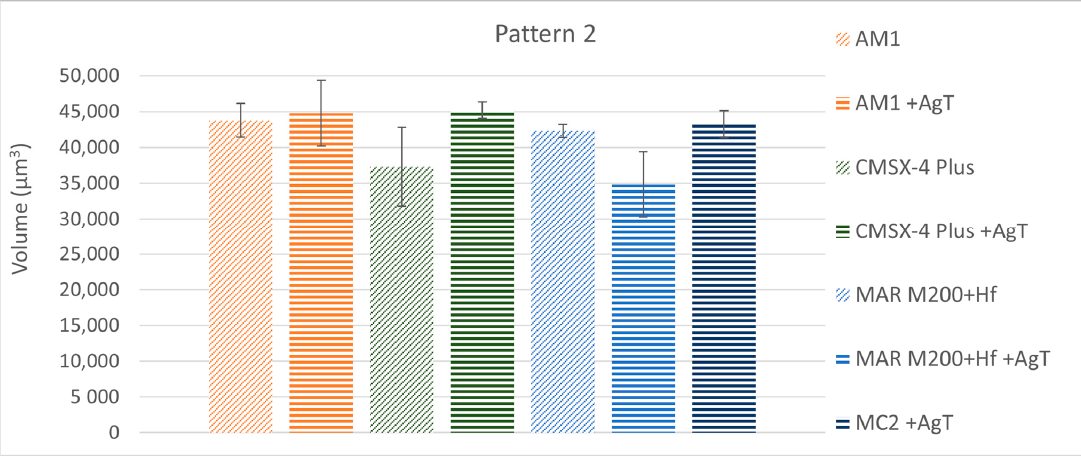
Table 4. Image analysis measurements of the equivalent diameter of γ ’ ‐ precipitates.